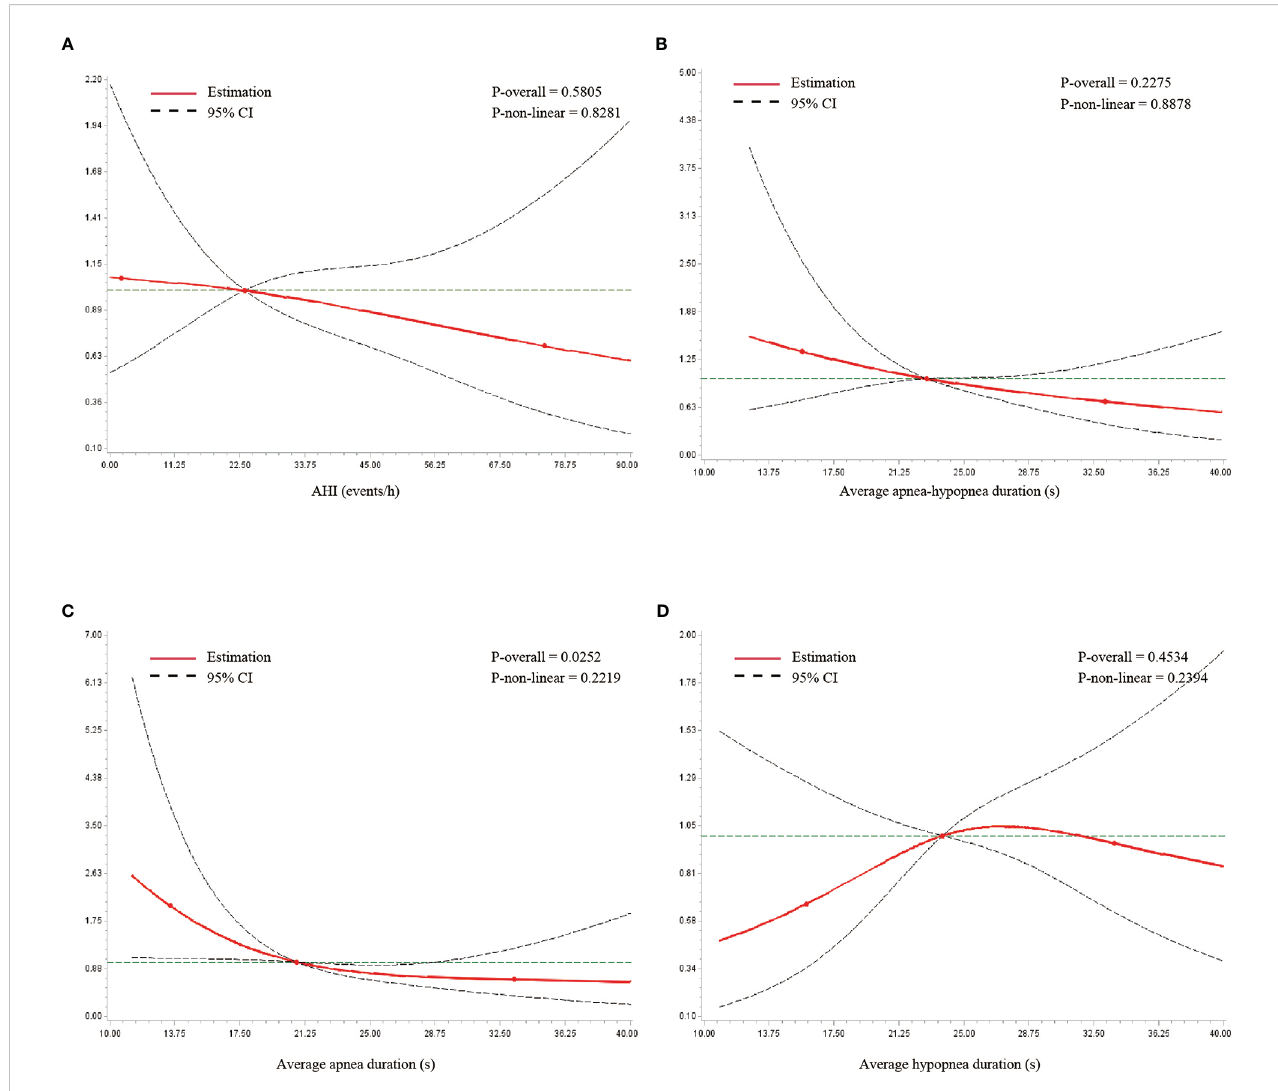
FIGURE 2 Restricted cubic spline analysis of metrics with type 2 diabetes. (A) AHI, (B) average apnea – hypopnea duration, (C) average apnea duration, and (D) average hypopnea duration. The overall and non-linear association were estimated by Wald chi-square